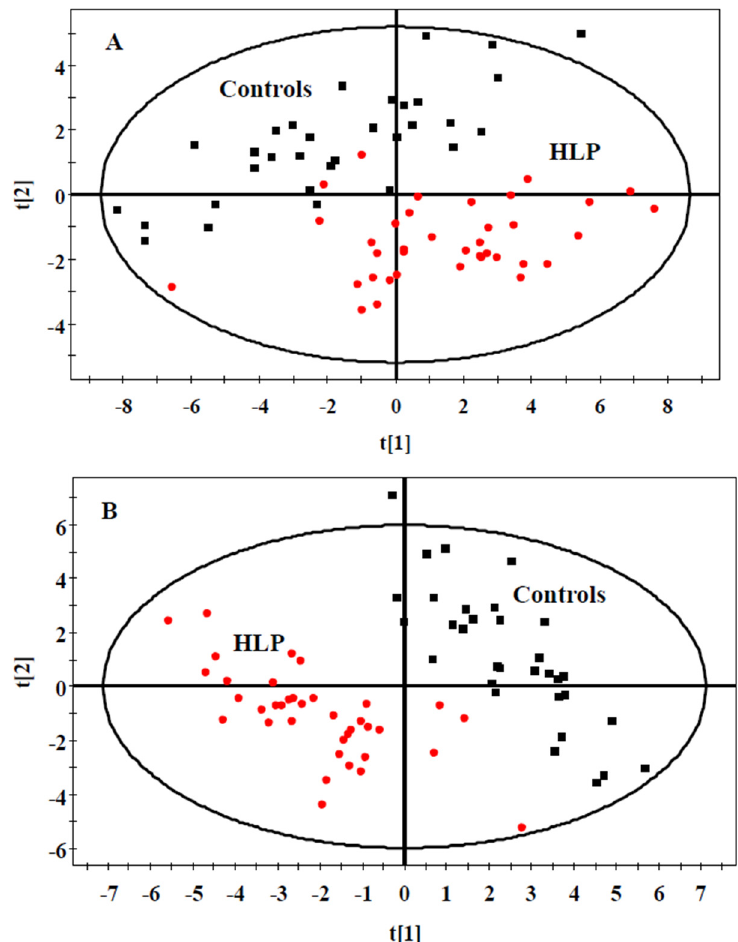
Figure 1. PCA ( A ) and PLS-DA ( B ) scores plot generated from serum samples data sets of the HLP and the healthy control groups. Squares (black), healthy control; Circles (red), HLP. Pprincipal component analysis (PCA), Partial least squares discriminate analysis (PLS ‐ DA).